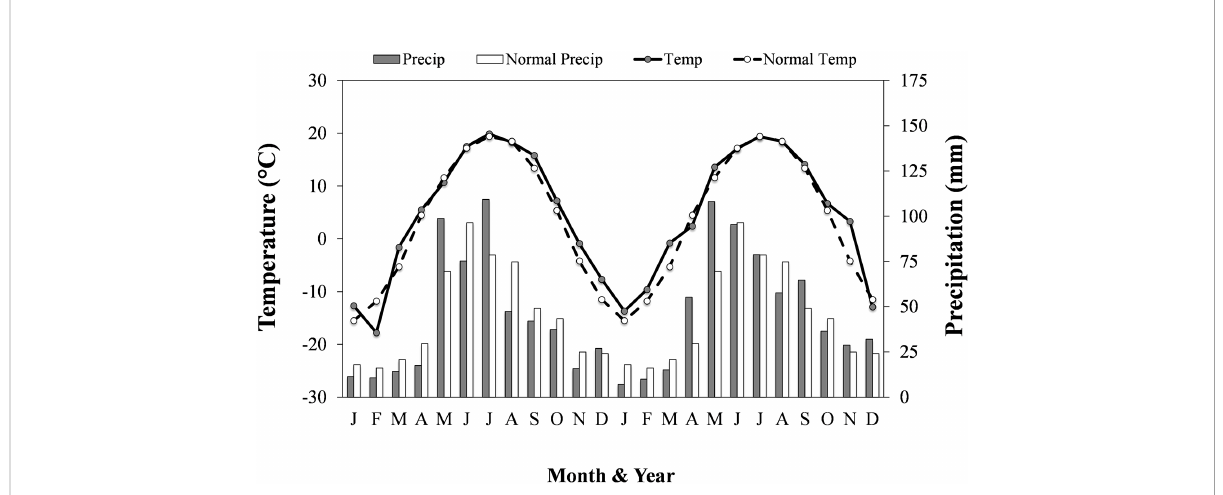
FIGURE 1 Mean daily air temperature (Temp; °C) and total precipitation (Precip; mm) for each month in each year of the study and the regional climatic normal (1980-2010) mean daily air temperature (Normal temp) and total precipitation (Normal precip) for each month. Adapted from: Environment Canada